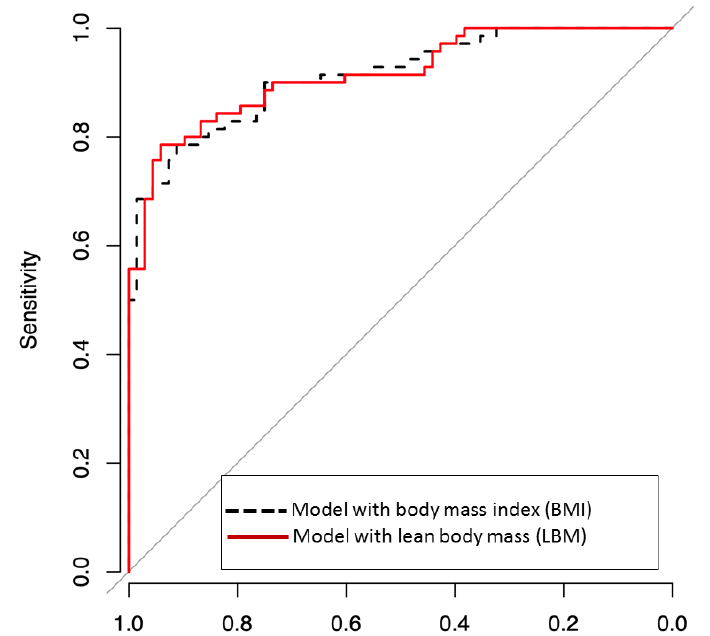
Figure 2. Receiver operating characteristic (ROC) curves for predicting good neurological outcome, defined as cerebral-performance categories 1–2, including body mass index (BMI) or lean body mass (LBM) in multivariate logistic models. Area under ROC curve (AUROC) was a good predictive value for BMI, and LBM predicted good neurological outcomes. The two models were not significantly different (AUROC of BMI vs. AUROC of LBM = 0.917 vs. 0.918, p- value = 0.8715).